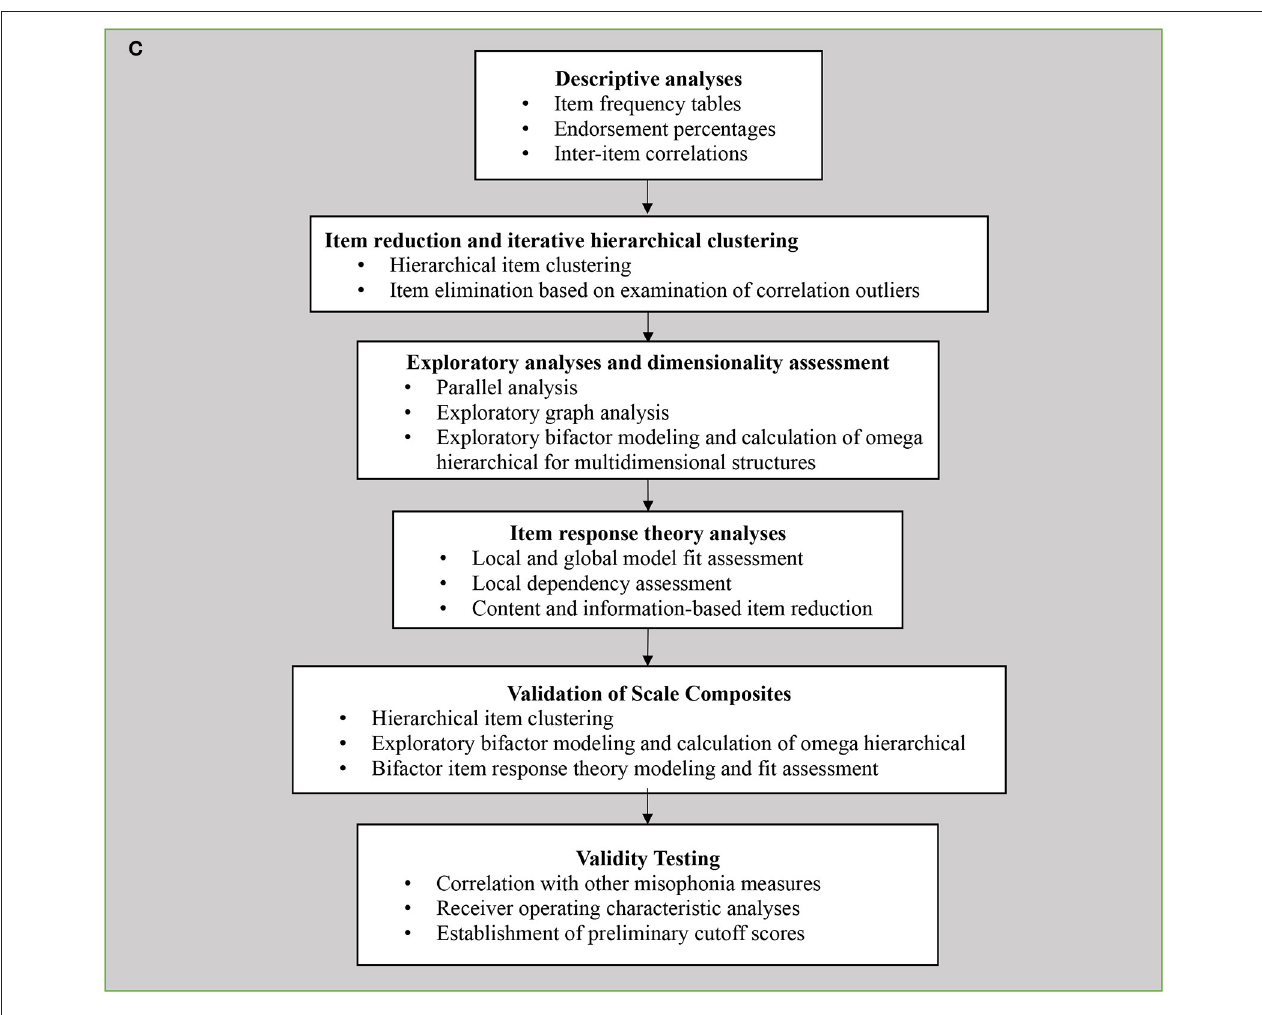
FIGURE 1 | (A) . Development of Item Pool. (B) Refinement of Item Pool. (C) Scale refinement using Psychometric Analyses. and loved ones of those with misophonia, the resulting candidate item pool included 372